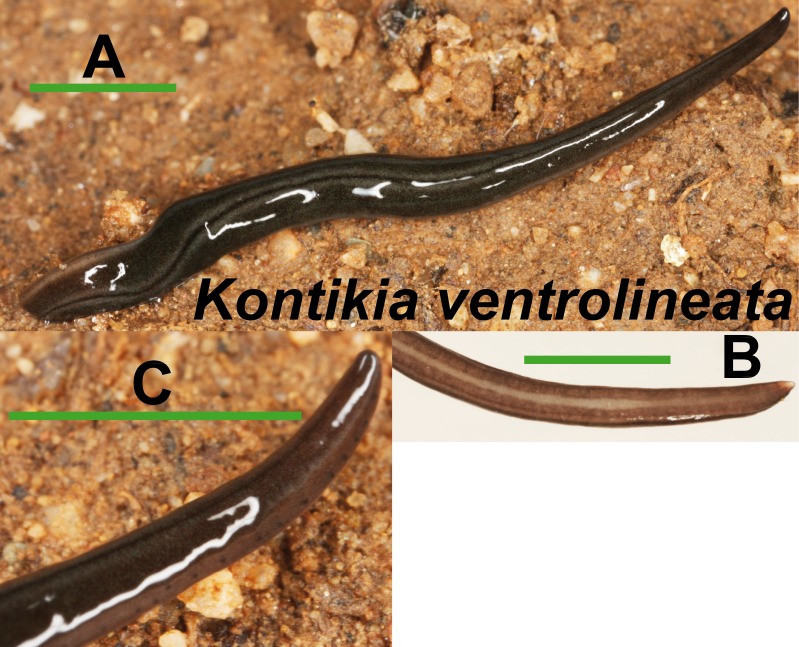
Kontikia ventrolineata.(A) Dorsal view. (B) Ventral view of posterior end. (C) Lateral view of anterior end showing line of eyes. Scale bar 5 mm.